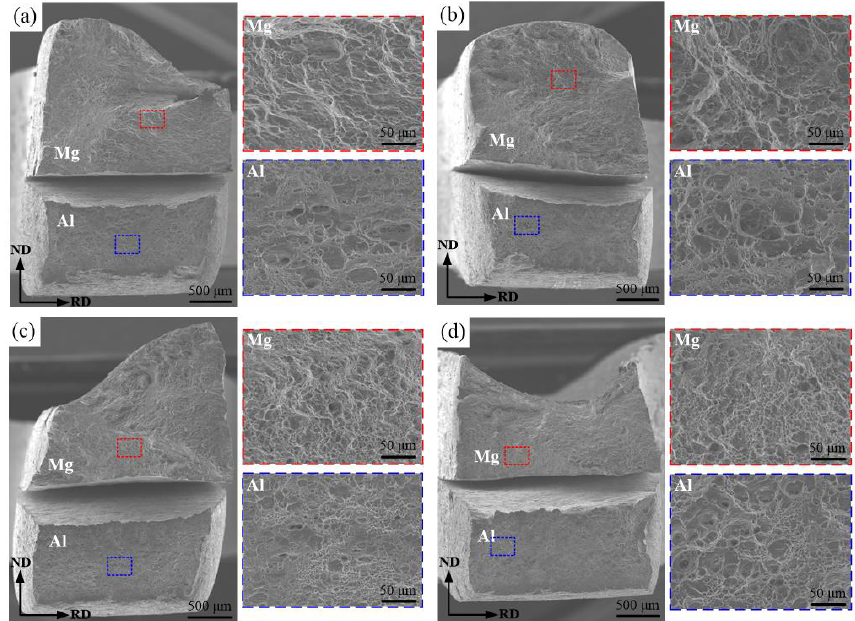
Figure 8. Tensile micro fractures of the corrugated clad sheet: ( a ) front waist; ( b ) peak; ( c ) back waist; ( d ) trough.